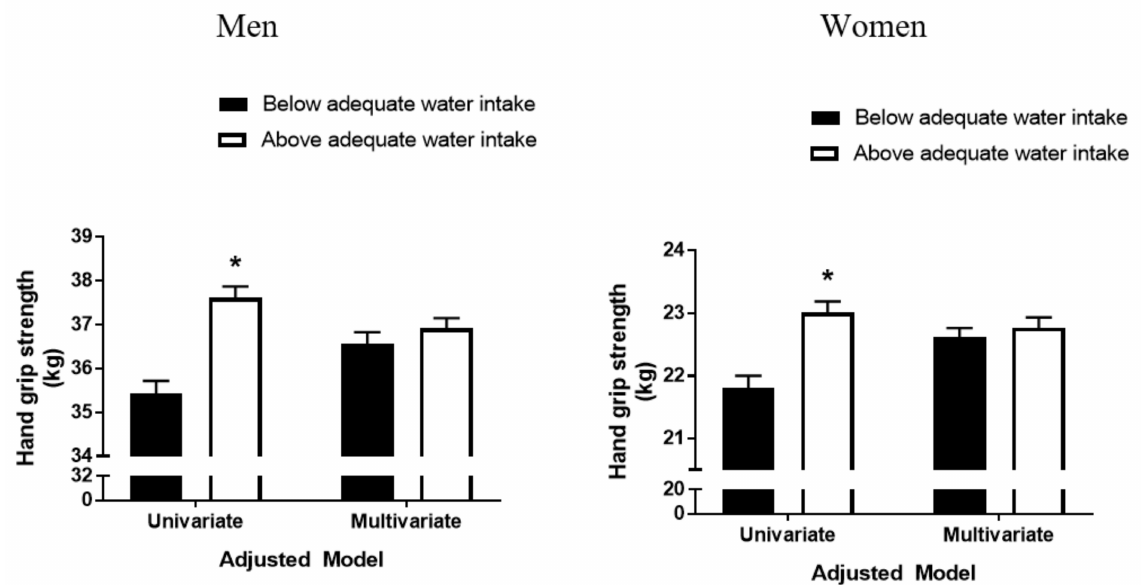
Figure 3. Differences in hand grip strength in men and women with below and above adequate water intake before and after adjustment for confounders. Results are expressed as estimated means with 95% confidence intervals based on analysis of covariance. Confounding factors included age, body mass index, resistance exercise, smoking status, heavy alcohol drinking, protein intake, and total energy intake. The cutoffs defining adequate water intake were >1000 mL in men and >900 mL in women. * Statistically significantly different from subjects with below adequate water